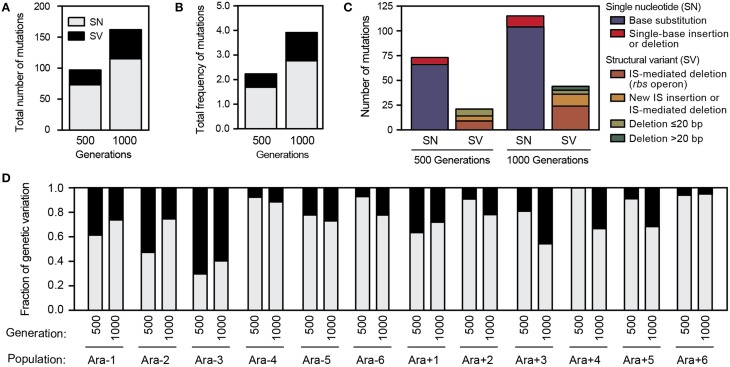
Mutations predicted in LTEE 500- and 1000-generation populations. (A) Total numbers of mutations detected across all 12 populations at each time point in each category. Single nucleotide (SN) mutations are single-base substitutions, insertions, and deletions. Structural variation (SV) mutations are insertions and deletions of ≥2 bases and other events such as IS element insertions, all of which are predicted from new sequence junctions by breseq. (B) Total frequencies of mutations detected across all 12 populations at each time point in each category. (C) Breakdown of the spectrum of molecular effects of all mutations detected within the 12 LTEE populations. (D) Fraction of total genetic variation contributed by SN vs. SV mutations in each LTEE population sample, weighted by mutation frequencies.